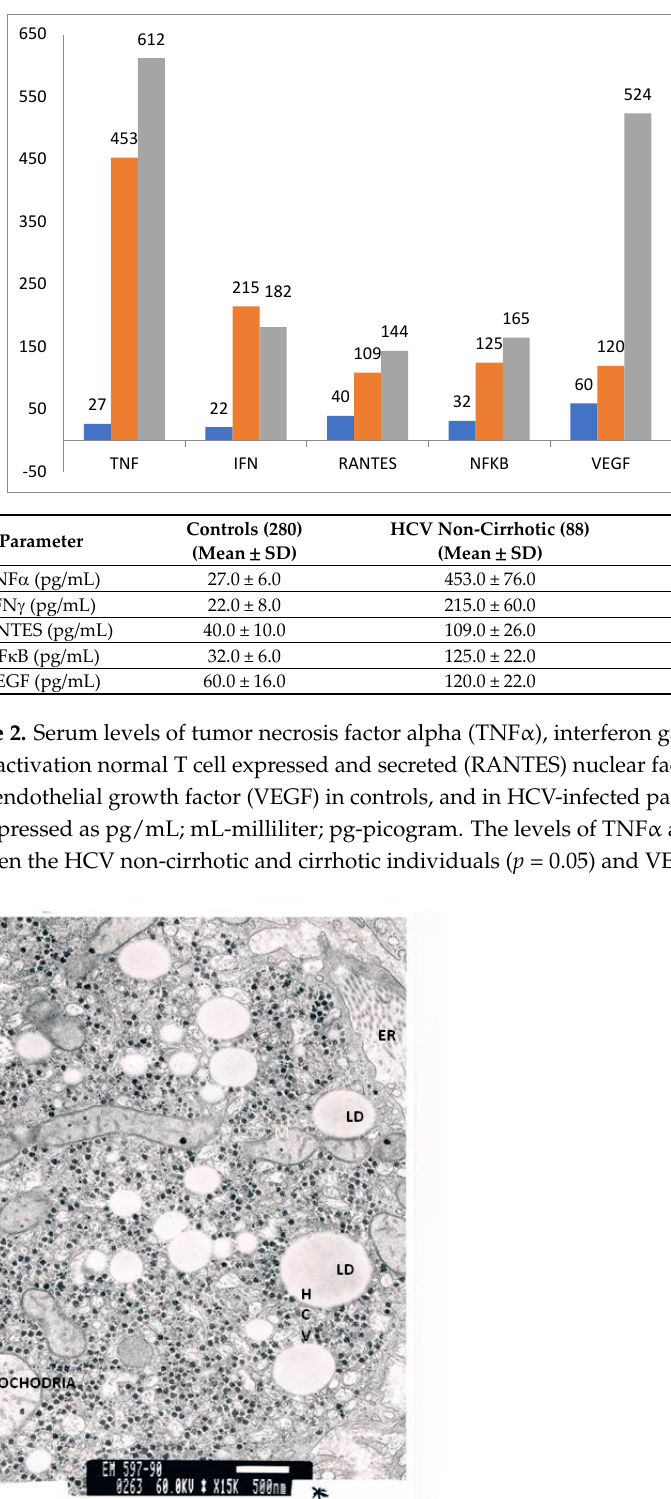
Figure 4. An electron micrograph of a liver biopsy of a patient, which shows hepatocytes containing large lipid droplets, enlarged endoplasmic reticulum, mitochondria with few cristae and HCV anti- bodies.